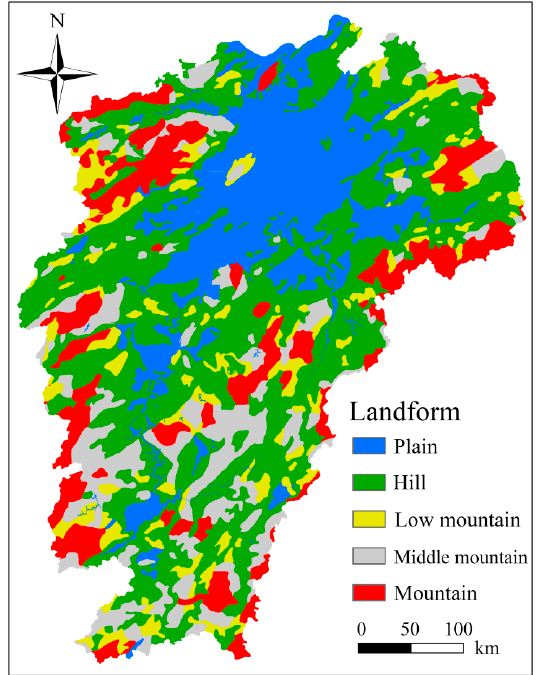
Figure 6. Landscape map with 1:250,000 scale in Jiangxi province.